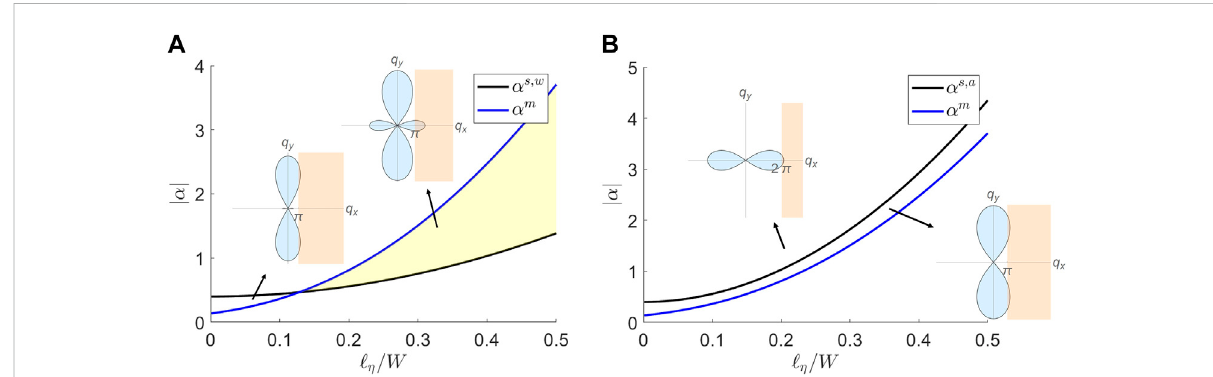
FIGURE 9 Linear instability for splay and the vortex-lattice state in the limits of weak and strong anchoring. In the insets, the orange regions delineate the values of wavector where the instability can occur, as discussed in Section 4.2. The yellow shaded region marks the range of parameters where α s , w < α m fl ow. For the strong anchoring limit, α m α s , a fl ow is possible. (A) c c , allowing for a region of coherent c is always smaller than c and no coherent Weak Anchoring ( ℓ κ → ∞ ). (B) Strong Anchoring ( ℓ κ